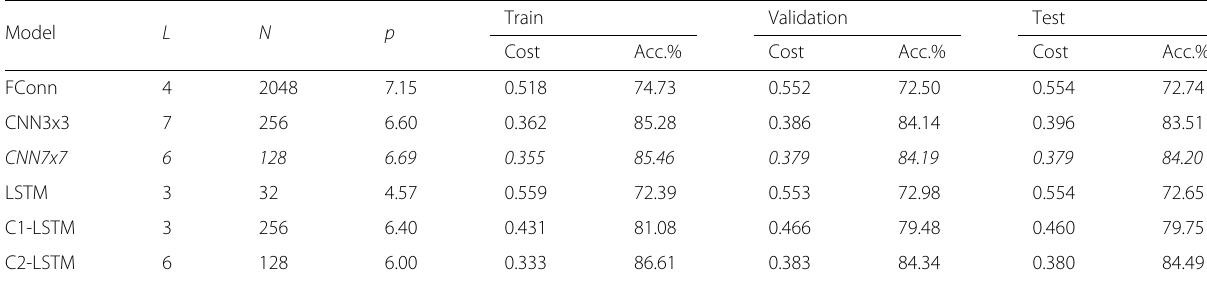
The Model column refers to the network architecture, L and N are the number of hidden layers and nodes in each layer (the detailed function of these parameters in each structure can be found in Section 3.3). p is a base-10 logarithmic measure of the number of parameters. The value of the cost or loss function and the clasiffication accuracy is included for the training, validation and test subsets. The best model in terms of validation cost is highlighted in